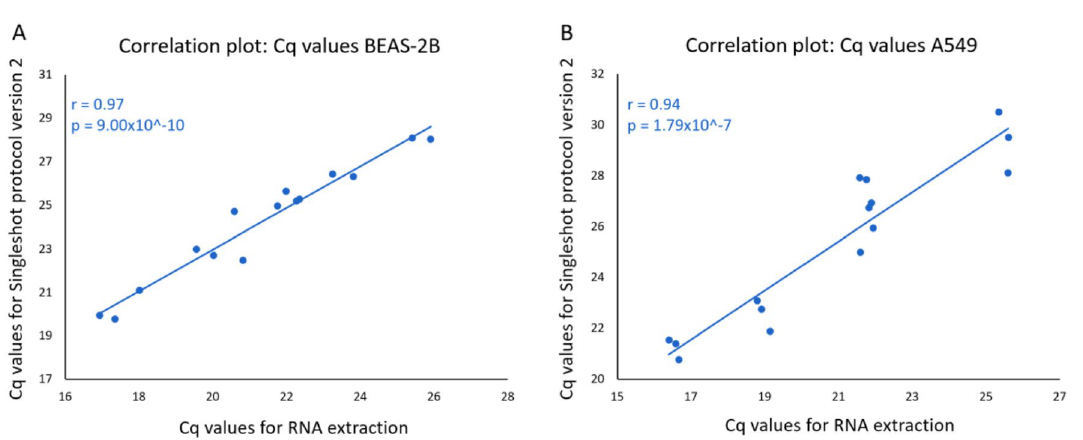
Figure 2. Correlation between Cq values from extracted RNA and lysate for lysis protocol version 2 in two different cell lines (BEAS-2B ( A ) and A549 ( B